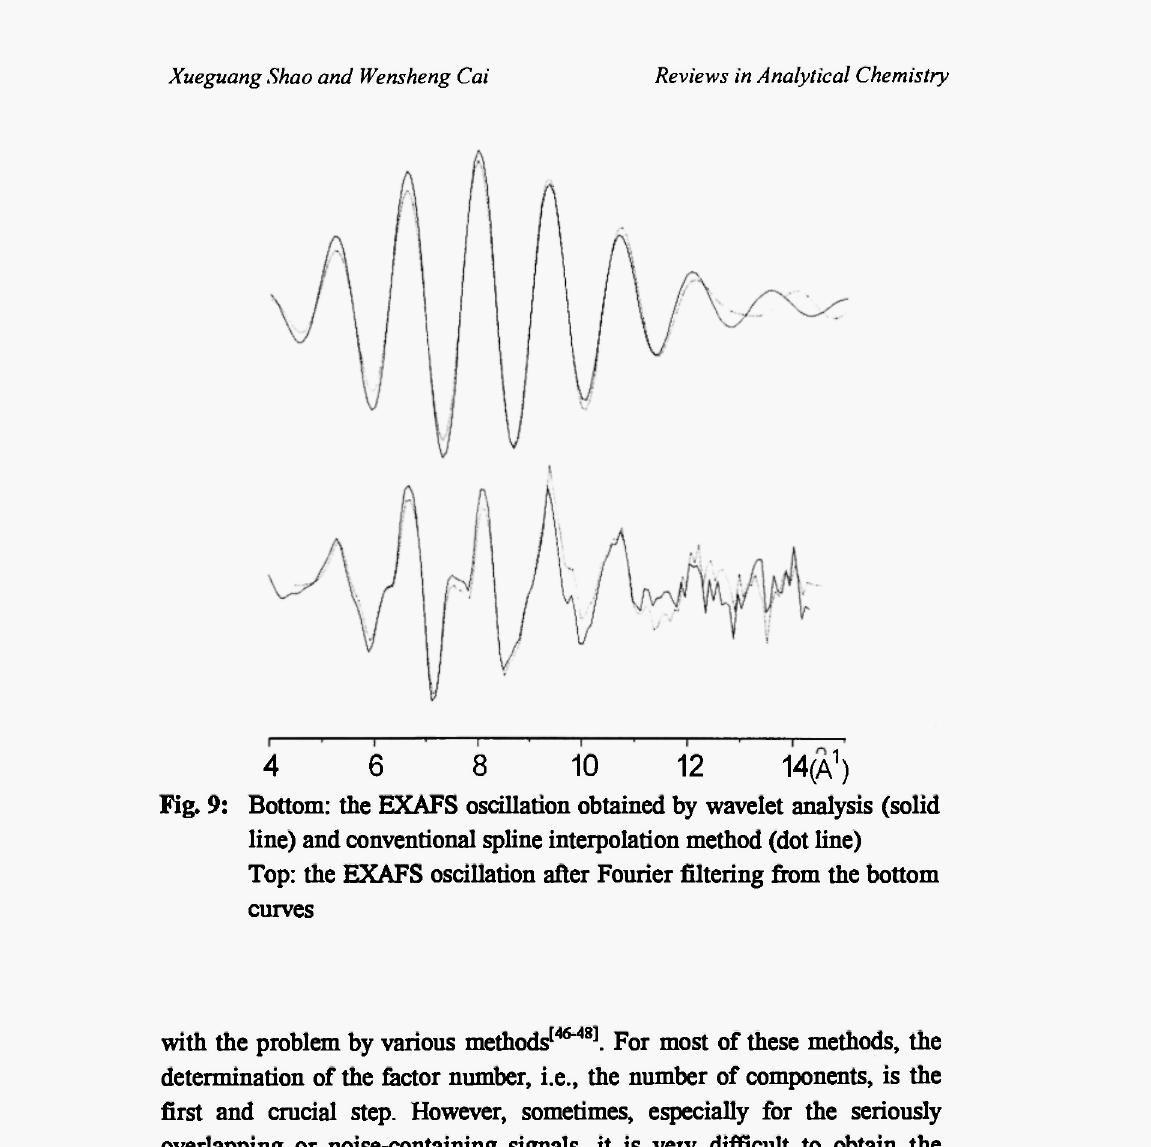
Fig. 9: Bottom: the EXAFS oscillation obtained by wavelet analysis (solid line) and conventional spline interpolation method (dot line) Top: the EXAFS oscillation after Fourier filtering from the bottom